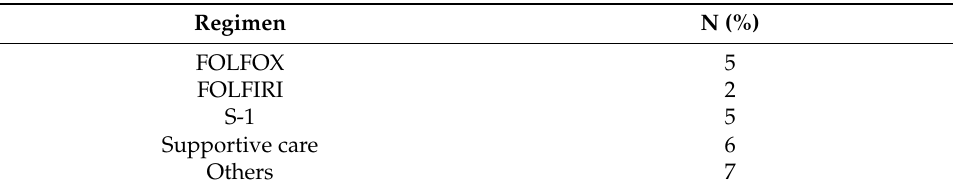
Table 6. Second line therapy after disease